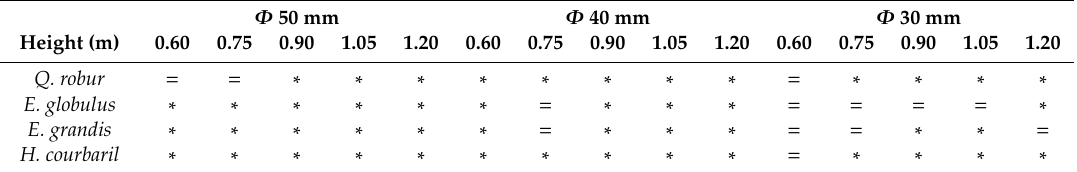
Table 7. Pairwise comparison indentation depth (ID) of solid wood flooring (SWF) vs indentation depth (ID) of engineered wood flooring (EWF) for the same drop height and same ball. Φ 50 mm